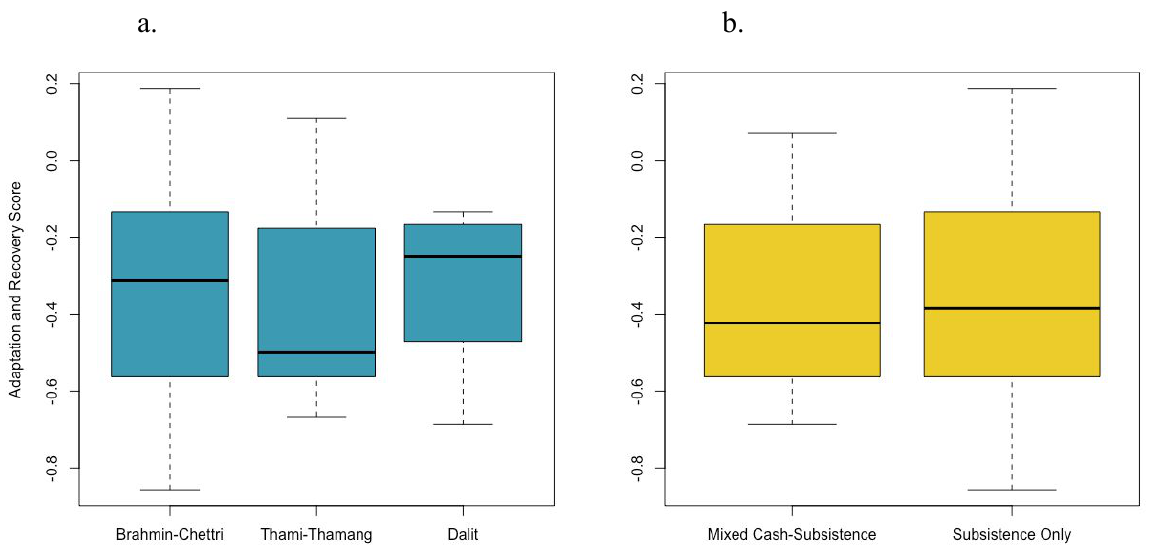
Figure A4.1a. & 4.1b. Box plots showing the distribution of adaptation and recovery scores at time “1 Year After EQ” between (a) castes and (b) the presence or absence of cash crops in farming systems. The variability within these groups vary, and highlights the range of resilience perceptions, even if the median is similar across groups. The box contains the middle 50% of the data, the upper edge of the box indicates 75th percentile of the data and the lower edge indicated 25th percentile. The black line inside the box is the median and the ends of the horizontal lines, the “whiskers”, represent minimum and maximum values. Plots showing analysis of community and household level variables are available upon request. ​ ​ ​ ​ ​ ​ ​ ​ ​ ​ ​ ​ ​ ​ a.